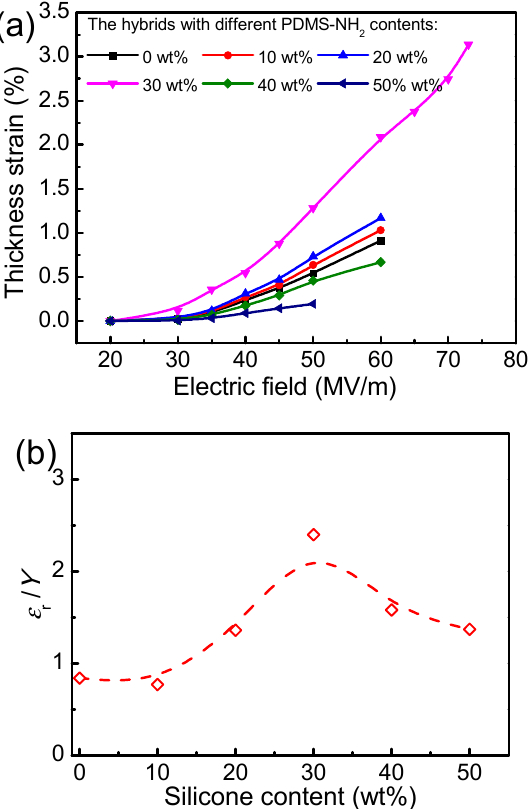
Figure 8. ( a ) Thickness strains of hybrids containing various silicone contents as a function of the electric field under room temperature, and ( b ) the maximum displacements and electromechanical efficiency of the hybrids with various silicone contents.